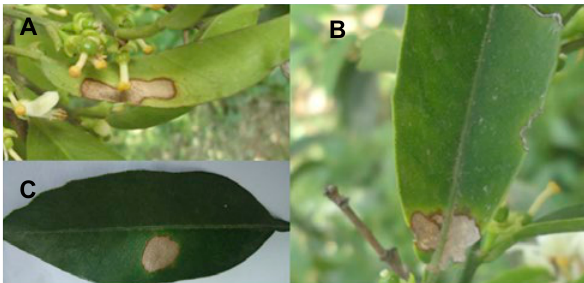
Figure 1. Symptoms on citrus twigs caused by Colletotrichum spp. A) wither-tip of twigs of clementine Cassar; B) orange conidiu masses of Colletotrichum spp. on twigs of clementine Cassar.